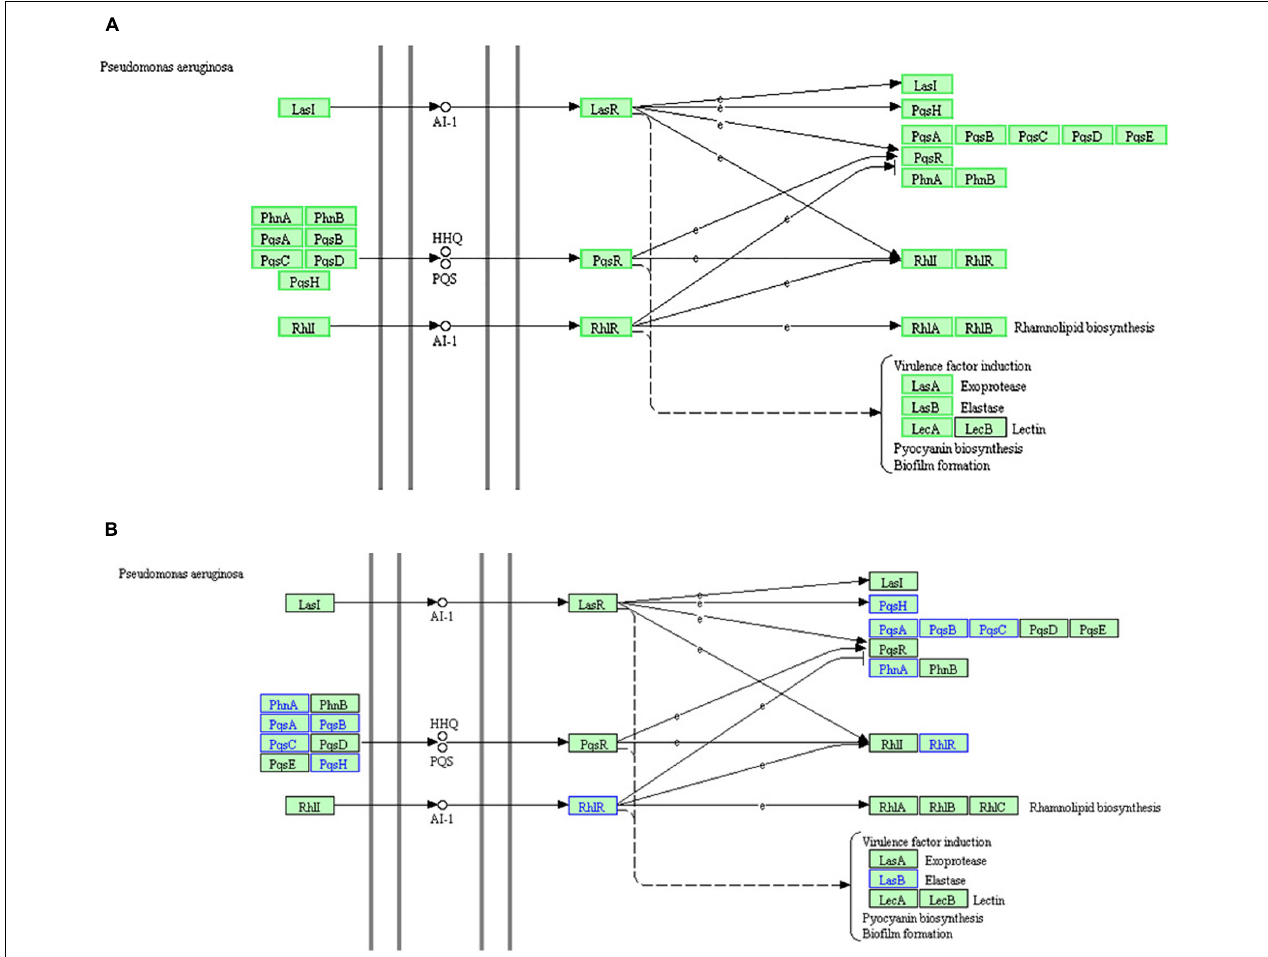
FIGURE 8 | The KEGG “quorum sensing” pathway based on RNA high-throughput sequencing analysis (A) and proteome high-throughput sequencing analysis (B) . (A) The green box proteins indicate that the RNA expression of the gene is down regulated, while the black box proteins show no changes in RNA expression. (B) Proteins in blue indicate downregulated expression, while proteins in black indicate no change in expression.